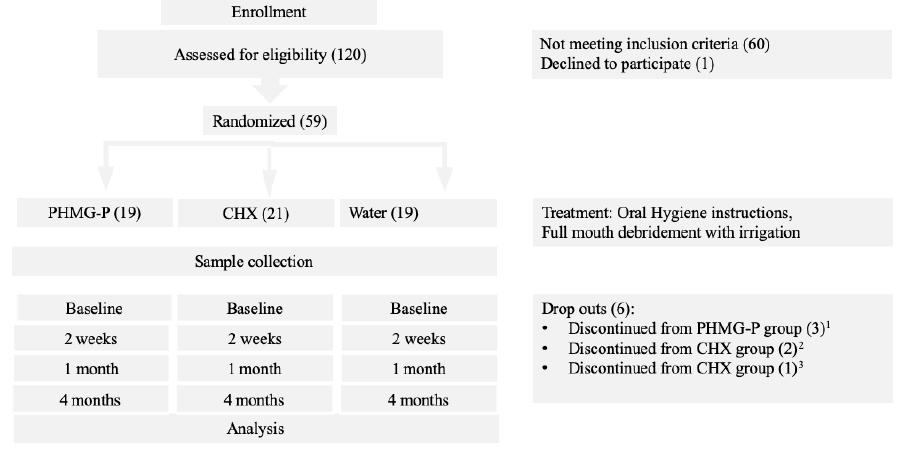
Figure 2. Dynamics of biomarkers in the course of the study. The levels of interleukin (IL)- 1β, IL -8, IL-10, IL-17A, and matrix metalloproteinase (MMP)-8 were evaluated in 59 patients with severe periodontitis, allocated to one of three treatment groups for scaling and root planing with adjunctive irrigants: Aquin (1% polyhexamethyleneguanidine phosphate (PHMG-P)) (n = 19), 0.2% chlorhexidine (CHX) (n = 21), or dH 2 O (n = 19). Cytokines were assessed